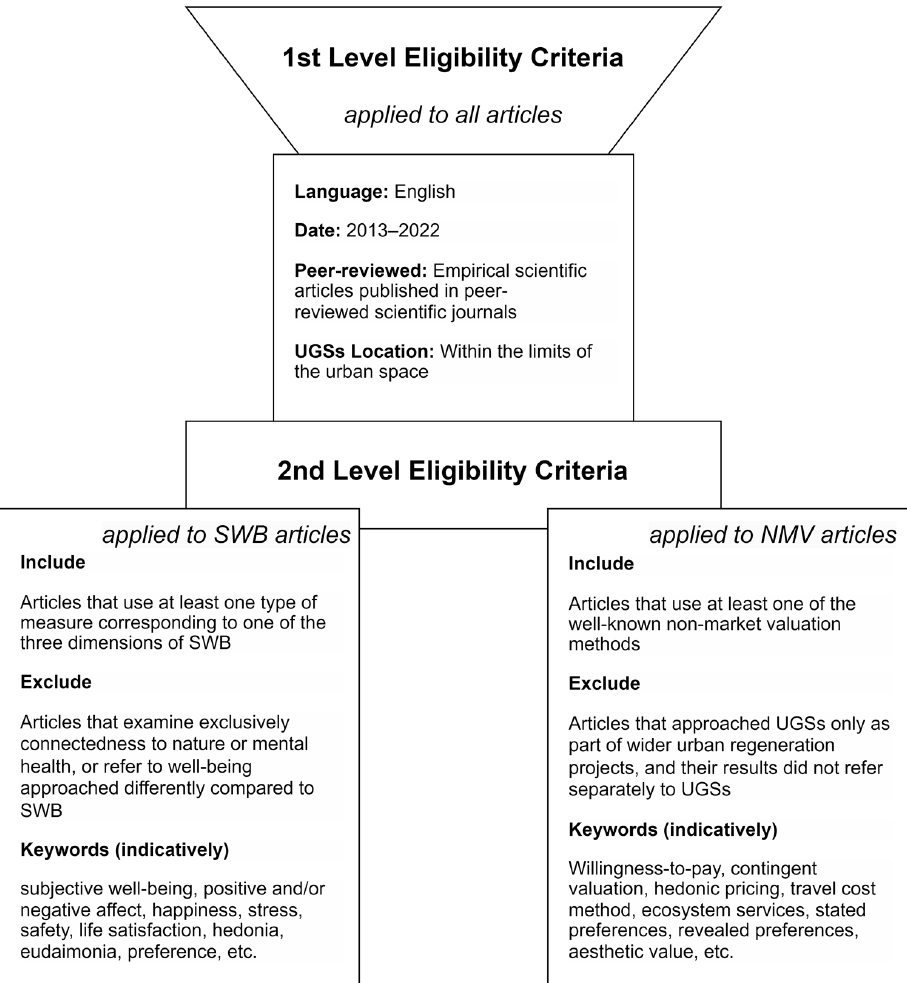
Figure 2. The sets of decision rules applied while reviewing the collected articles.